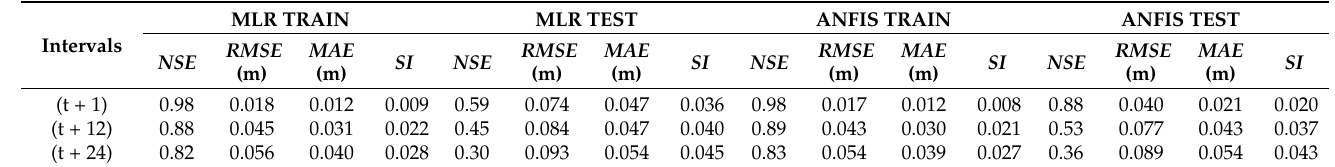
Table 2. Statistical performance of the SC1 -based MLR and ANFIS